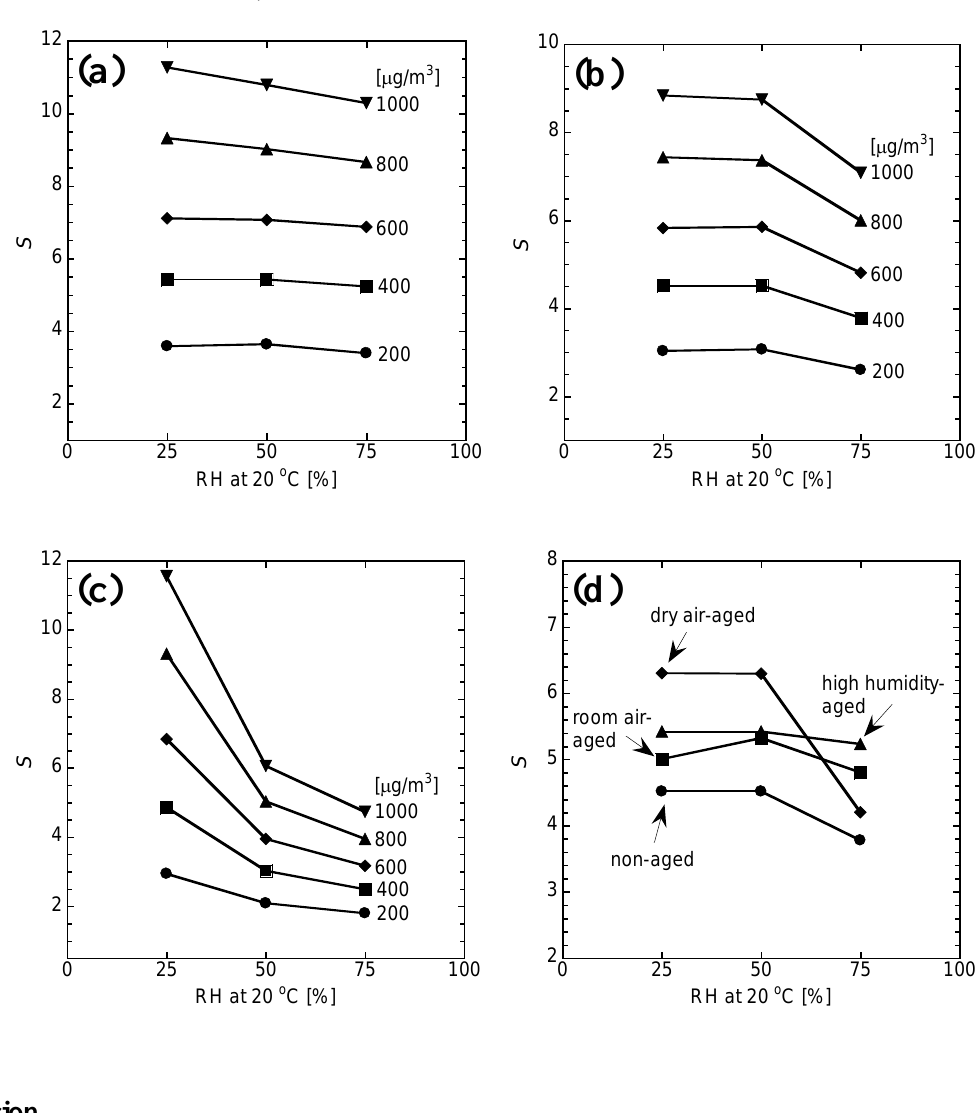
Figure 3. Sensor response ( S ) of (a) high-humidity aged Pt,Pd,Au/SnO Pt,Pd,Au/SnO , (c) high-humidity aged Pt/SnO 2 gas concentration; (d) non, dry air, room air, and high-humidity aged Pt,Pd,Au/SnO several humidity and 400  g/m 3 T–VOC test gas